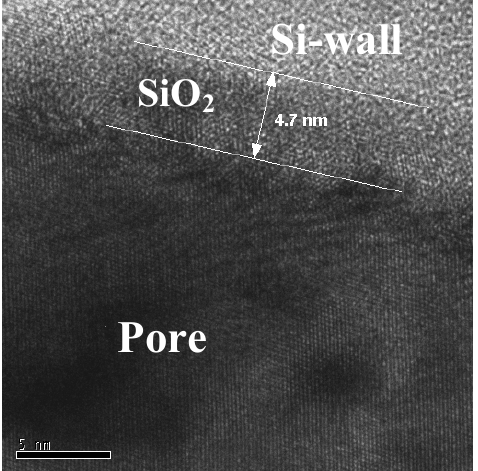
Figure 35. HRTEM-image of porous silicon, showing a native oxide layer of about 5 nm covering the pore-wall.